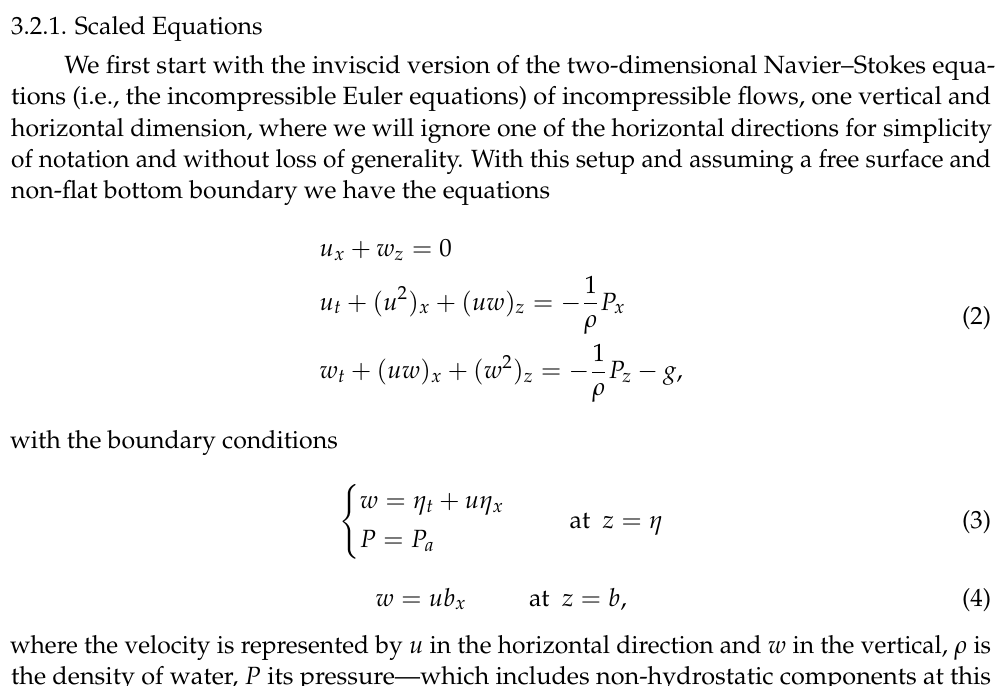
Figure 6. Gravity-centered, depth-averaged coordinate system for the shallow water equations. Here h is the depth of the water column; η the difference between a defined datum, commonly a given sea-level, and the sea-surface; and b the bathymetry surface as measured from the same